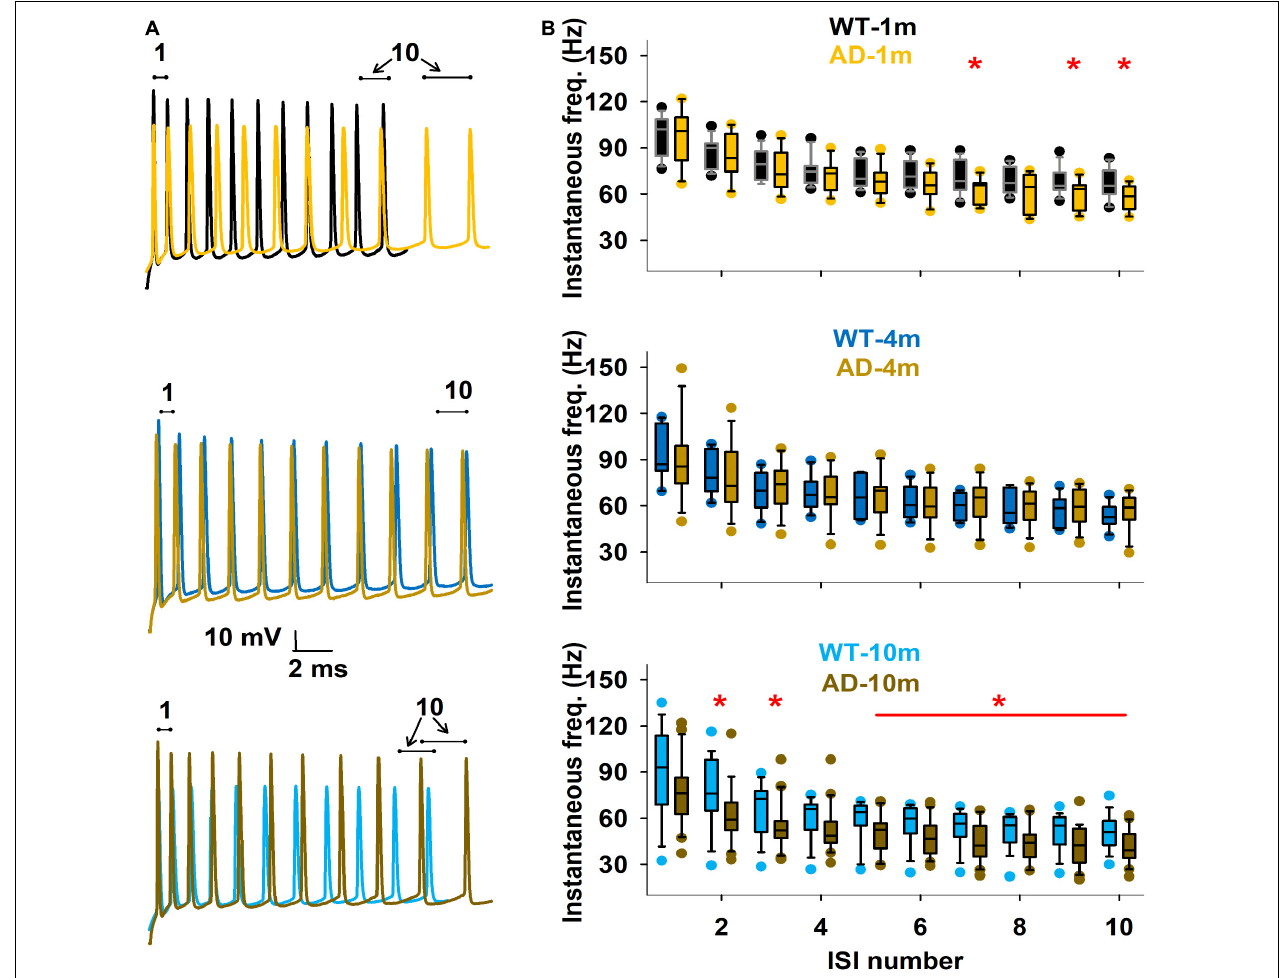
FIGURE 6 | Differences in firing frequency. (A) Enlargement of the traces to illustrate first 11 spikes in typical experimental traces at 300 pA for each age, under Control and AD conditions. (B) Box plot of instantaneous firing frequency calculated from the first 10 inter-spike intervals, for the different conditions. The red line and symbols in the graphs indicate currents for which the average values were significantly different. * p ≤ 0.05. See full statistical analysis for these features in Supplementary Table 4